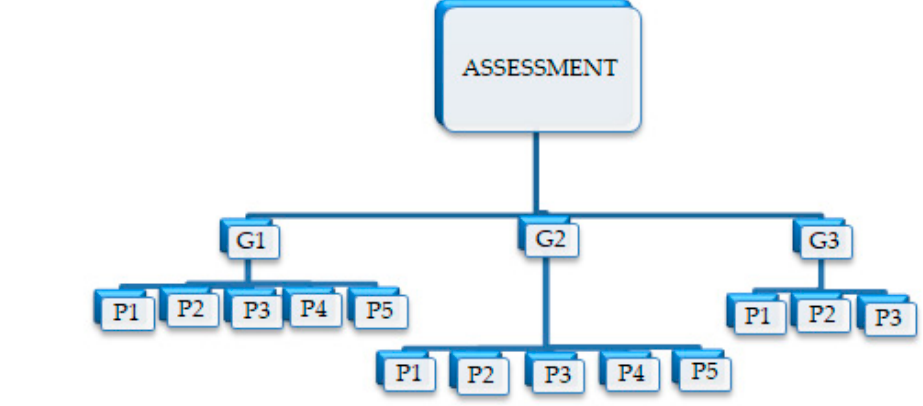
Figure 6. Diagram of the hierarchy